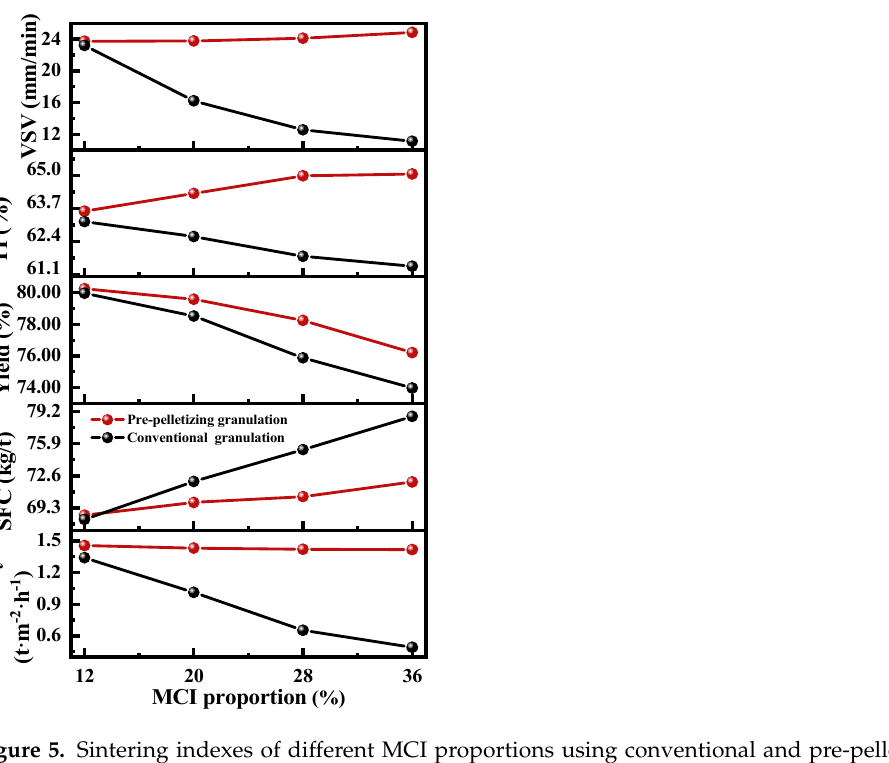
Figure 5. Sintering indexes of di ff erent MCI proportions using conventional and pre-pelletizing granulation.